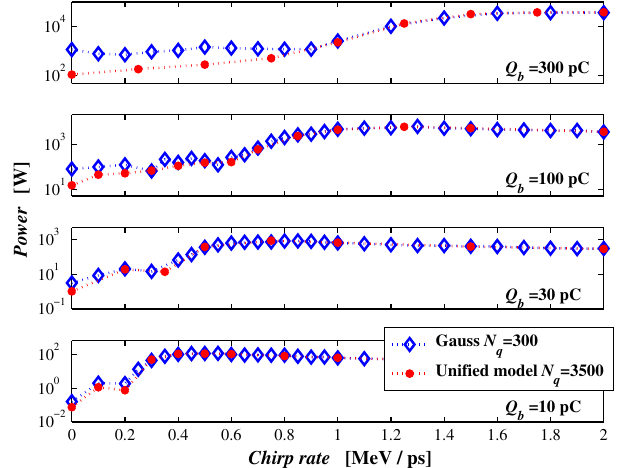
FIG. 4. ECSE FEL power dependence on the chirp rate (the bunch duration is f s T b ≈ 1 ). Random Gauss initial distribution of N 300 charged particles, and unified model of electron beam q ¼ shot noise ( N q ¼ 3500 ) with a Gaussian form beam current density profile.